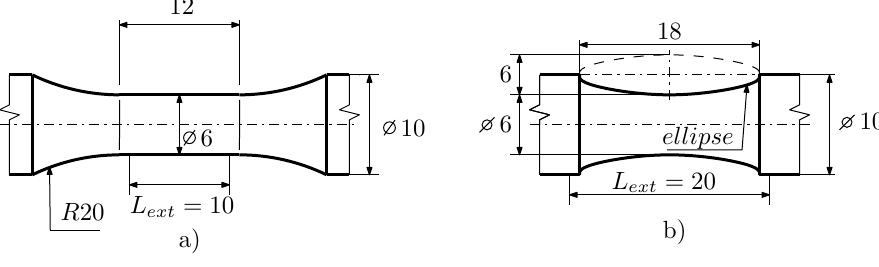
Figure 9. Specimen geometries: ( a ) uniform-gauge; ( b )